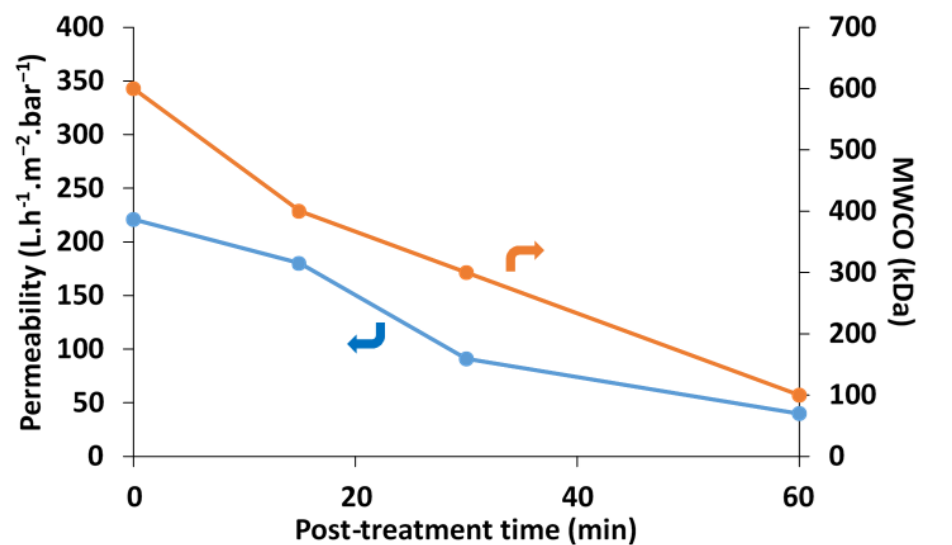
Figure 9. Variation in PWP and MWCO as a function of the cross-linking